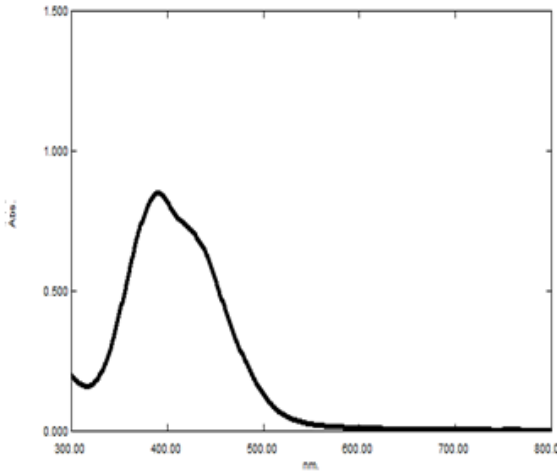
Figure 11: Absorption spectrum of 4-APAP in